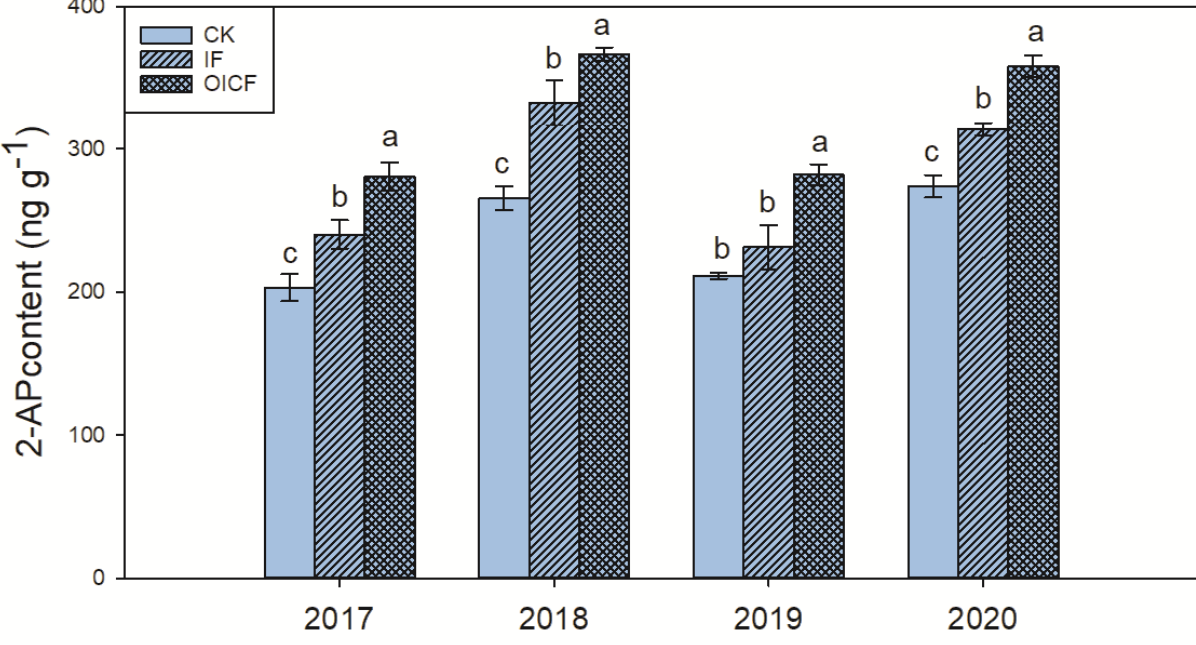
Figure 4. Effects of new organic-inorganic compound fertilizer on grain 2-AP content of fragrant rice. Bars sharing a common letter do not differ significantly at p ≤ 0.05.